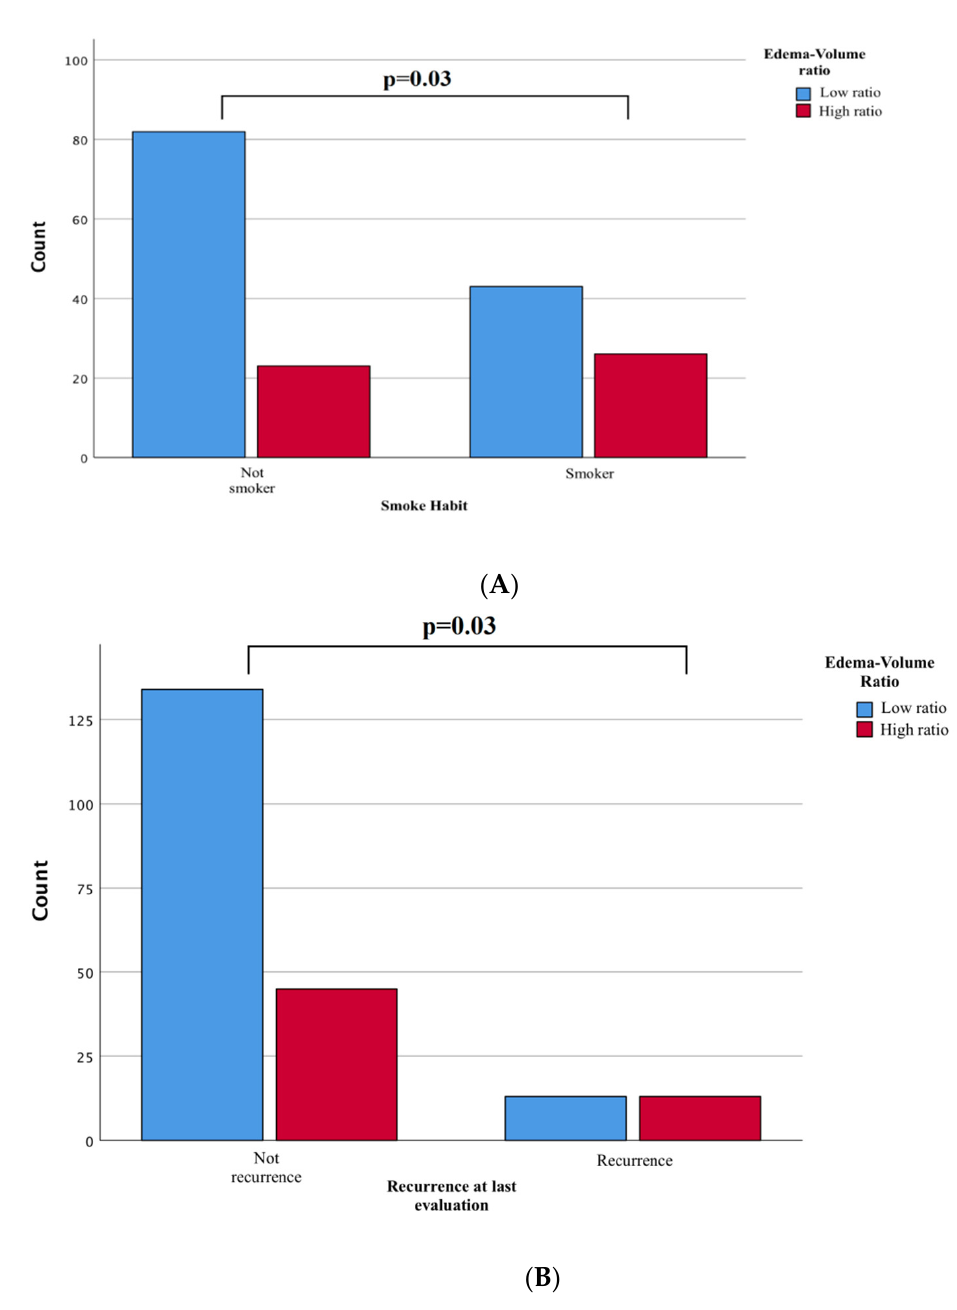
Figure 3. ( A ): Chi ‐ square Comparison Analysis shows statistically significant differences in the smoking habit in subjects with a high edema ‐ to ‐ tumor volume ratio ( p = 0.03). ( B ): significantly increased risk of developing recurrence independently compared with meningiomas with a low ratio ( p = 0.03).